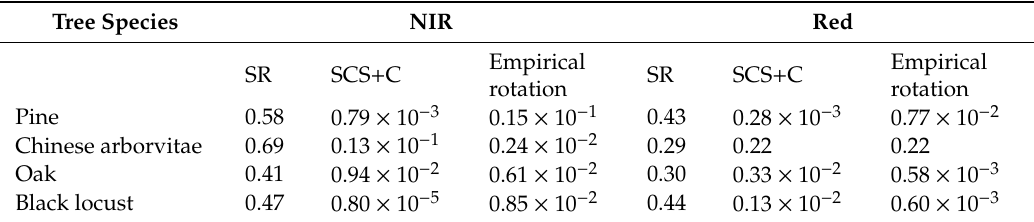
Table 3. Correlation coe ffi cient of spectral band and illumination conditions (IC) before and after correction in the NIR band and red band. SR represents the coe ffi cient before correction, SCS + C represents the coe ffi cient after correction by SCS + C model, and empirical rotation represents the coe ffi cient after correction by the empirical rotation